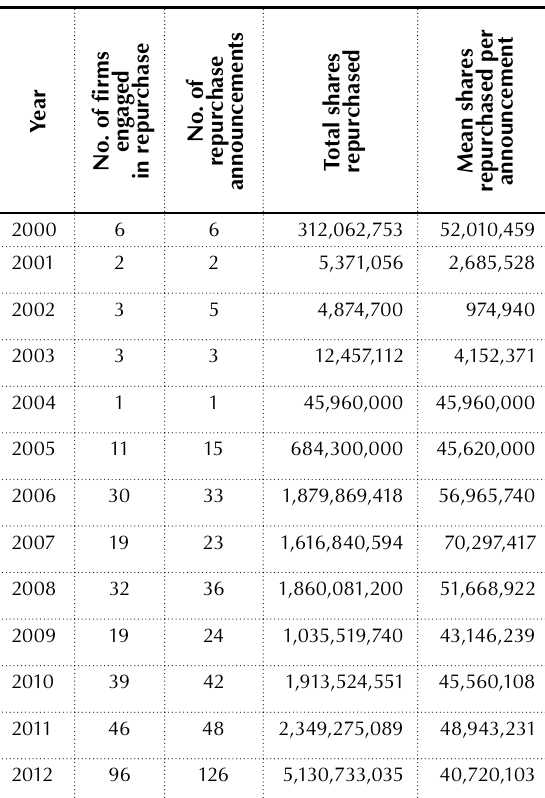
Table 2. Summary for share repurchases